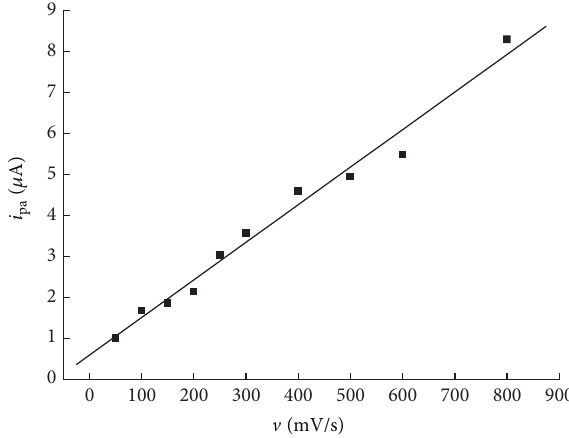
Figure 3: Relationship between 𝑖 pa and V